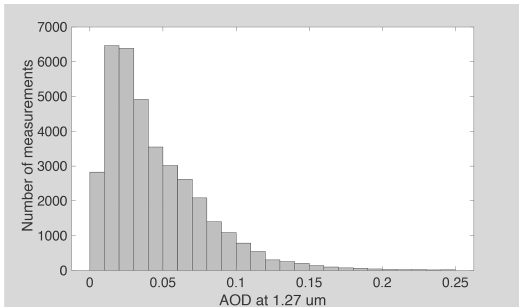
Figure A2. AOD in the 1.27µm O 2 absorption band estimated from AERONET observations (2010–2017).